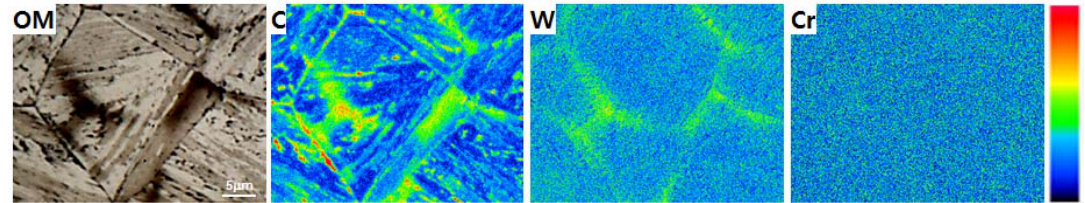
Figure 12. Electron probe micro ‐ analyzer (EPMA) mapping results showing the distribution of elements in coarse grain heat ‐ affected zone (CGHAZ).